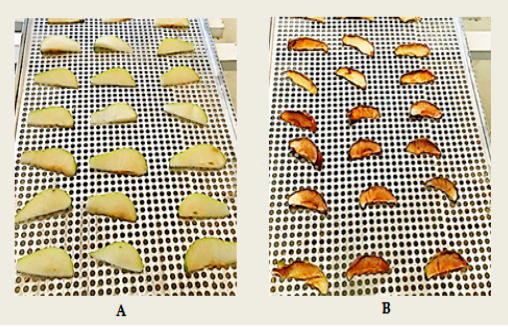
Figure 4. Before and after the drying process pear images: ( A ) before drying; ( B ) after drying.